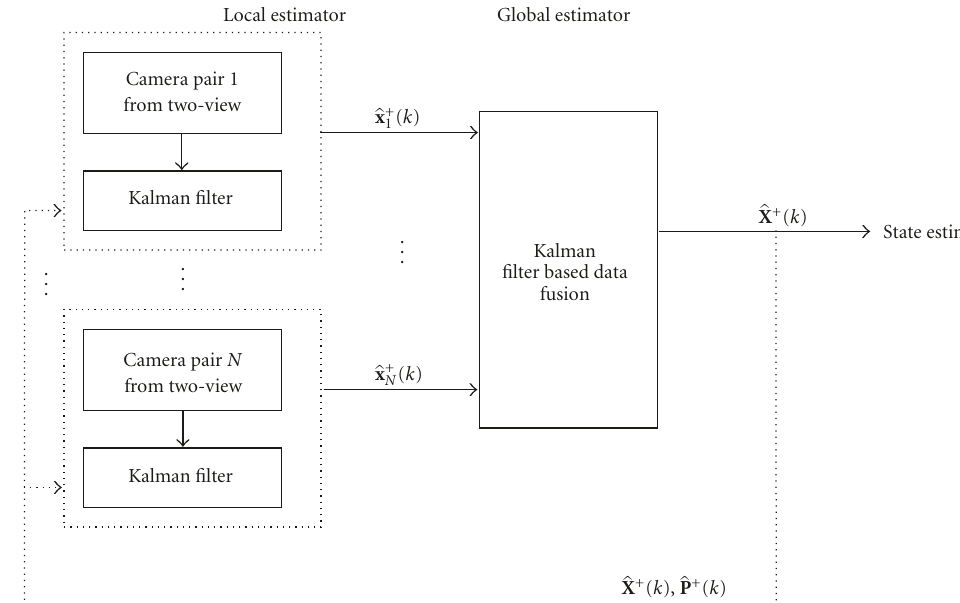
Figure 1: Proposed Kalman-filter-based hierarchical estimator for object tracking.